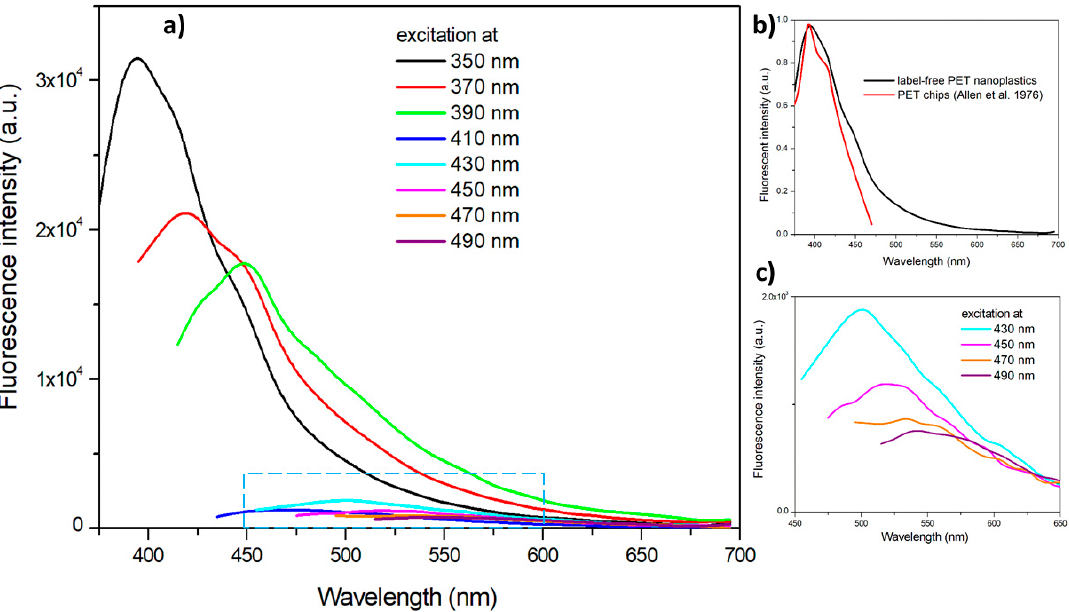
Figure 4. ( a ) Fluorescence emission spectra: ( a ) label-free PET nanoparticles dispersed in distilled water at different excitation wavelengths; ( b ) comparison of emission spectra at 350 nm excitation of label-free PET nanoparticles and PET chips reported by Allen et al. [54]; ( c ) magnification of the spectra area hatched in light blue, referring to emission spectra of label-free PET nanoparticles excited in the 430–490 nm range.